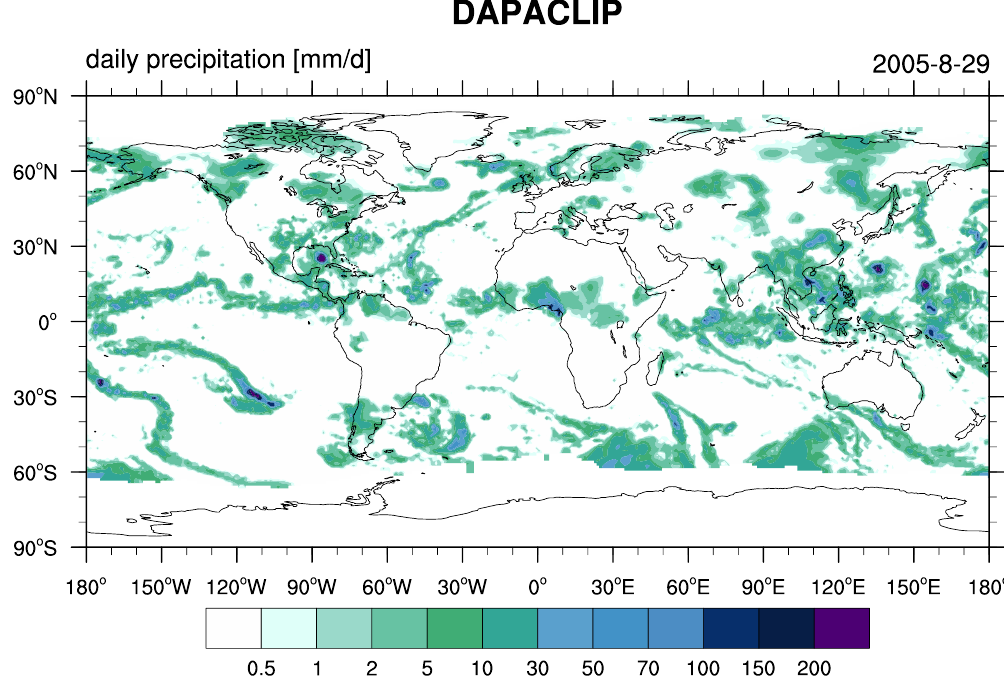
Figure 4. Example of the merged Daily Precipitation Analysis for Climate Prediction dataset (DAPACLIP) from land and ocean data for 29 August, 2005. Remarkable features from distinct events can be seen, for example the precipitation pattern of hurricane Katrina at the Gulf of Mexico and several tropical storms in the western Pacific